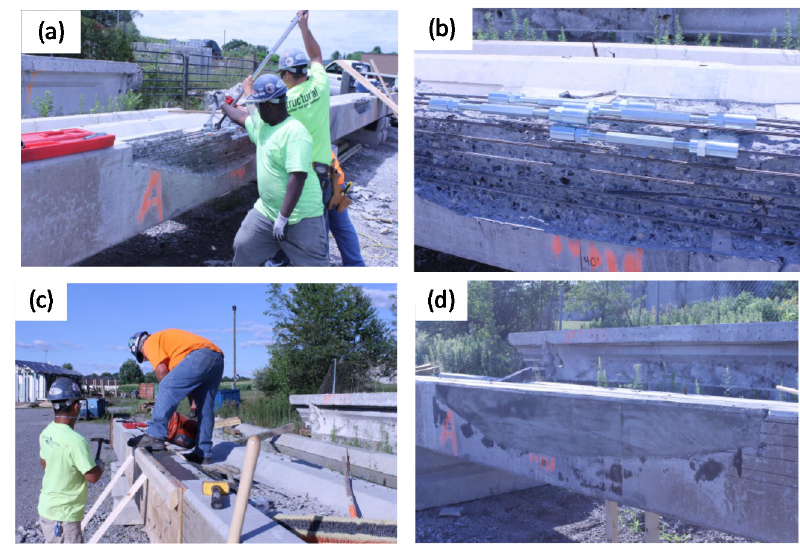
Figure 11. Repair procedure using strand splices: ( a ) installation of the strand splices, ( b ) completed installation of splices, ( c ) placing the repair concrete, and ( d ) completed repair after form removal (adopted from [19]).